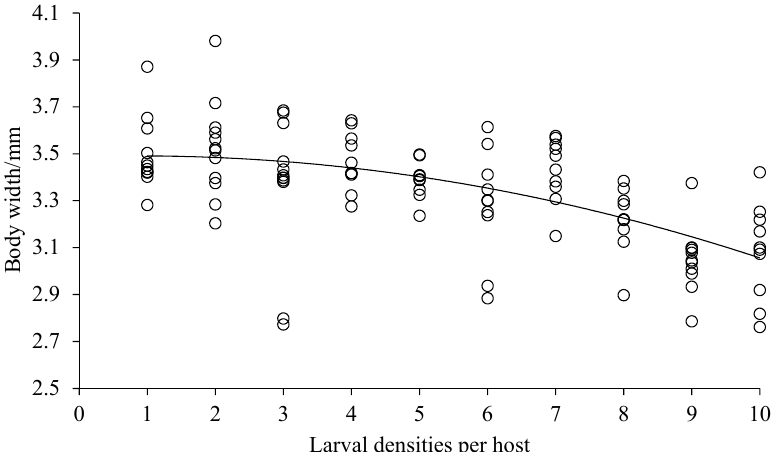
Figure 3. Body width of D. helophoroides adults emerging per host with various larval densities. Relationship between larval densities per host and body width of D. helophoroides adults ( y = − 0.0052 x 2 + 0.009 x + 3.4871; adjusted r 2 = 0.8499, p = 0.0001).